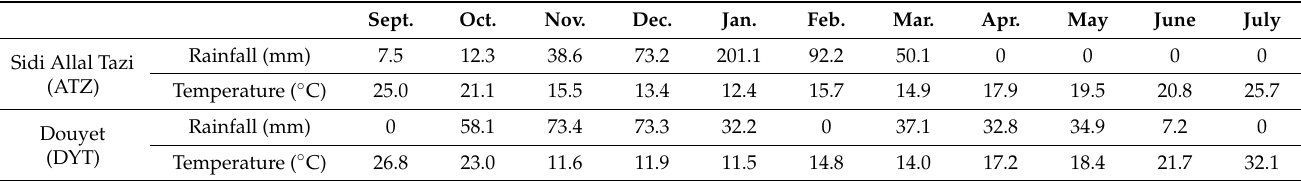
Table A1. The monthly rainfall and mean temperature recorded in Sidi Allal Tazi and Douyet locations during the cropping year